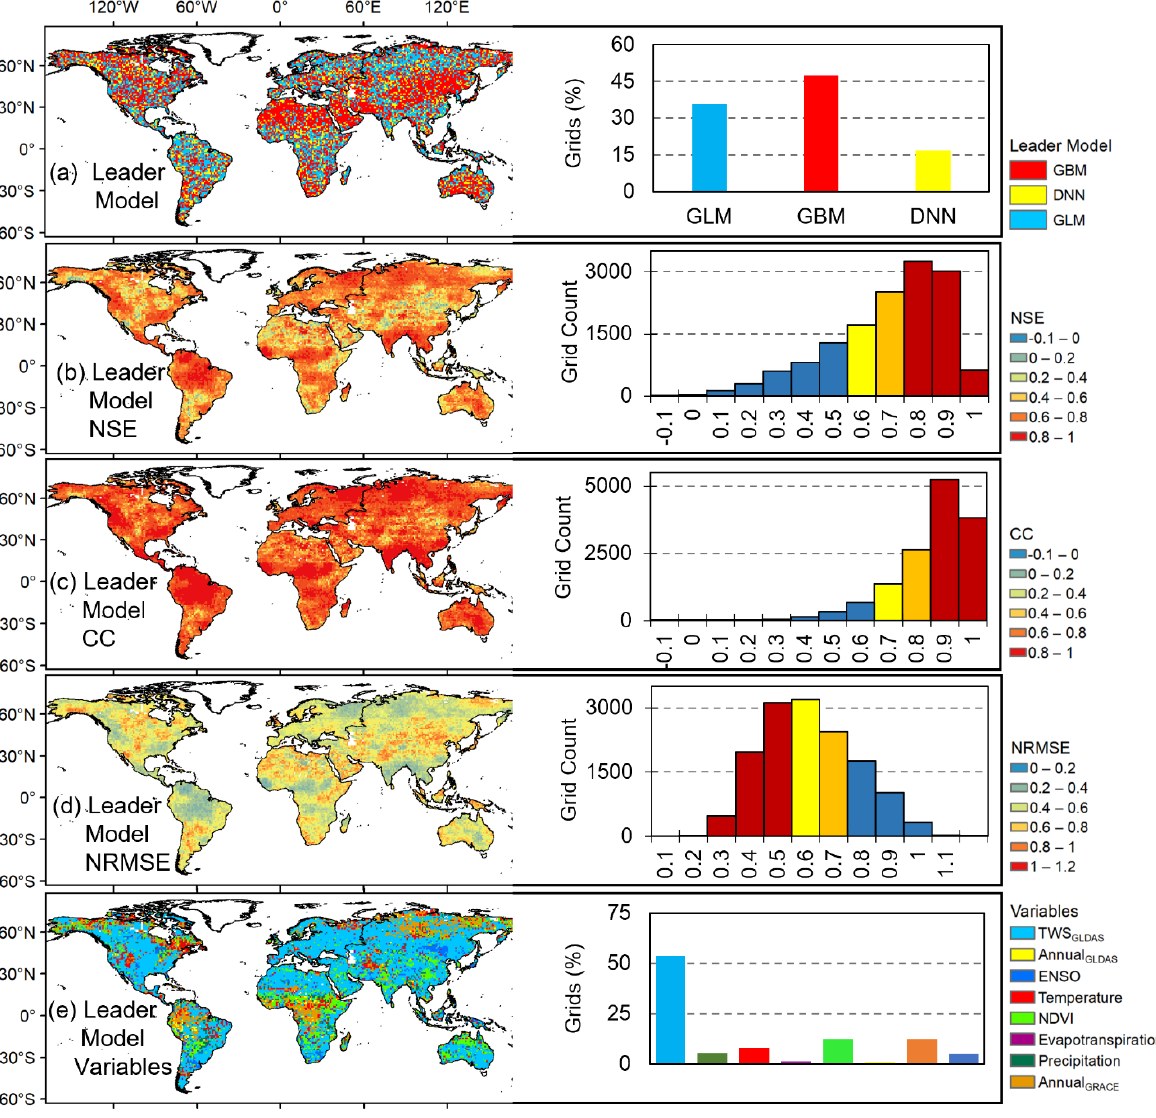
Figure 6. Spatial ( left ) and frequency ( right ) distributions of the grid-scale leader model ( a ) types, ( b ) testing NSE, ( c ) testing CC, ( d ), testing NRMSE, and ( e ) variable importance. The color-coded frequency distribution shows the very good (red), good (orange), satisfactory (yellow), and poor (blue) performance categories.